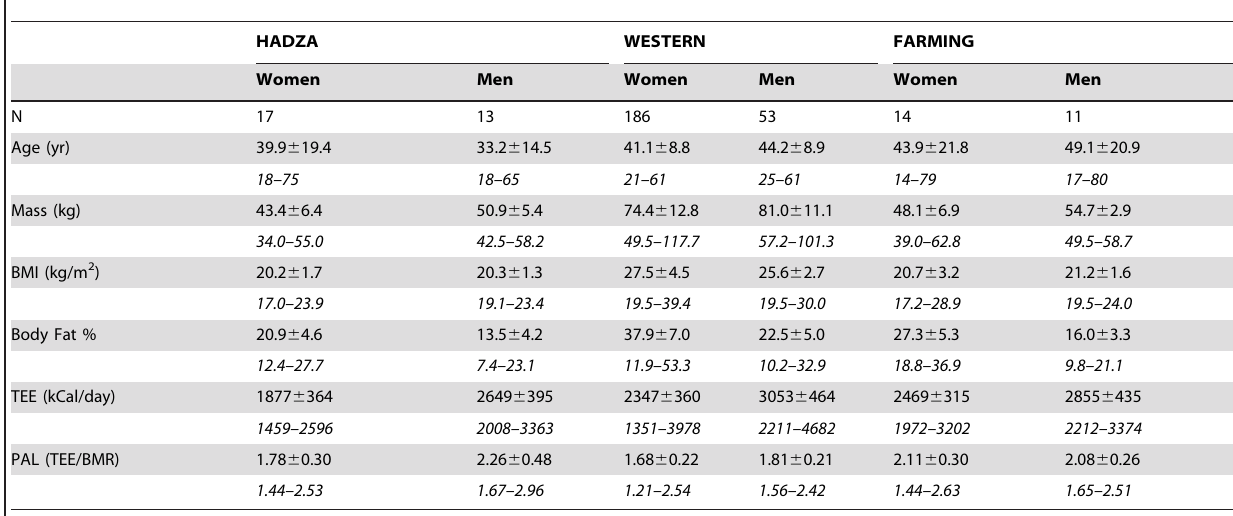
Table 1. Population characteristics, energy expenditure, and body composition.